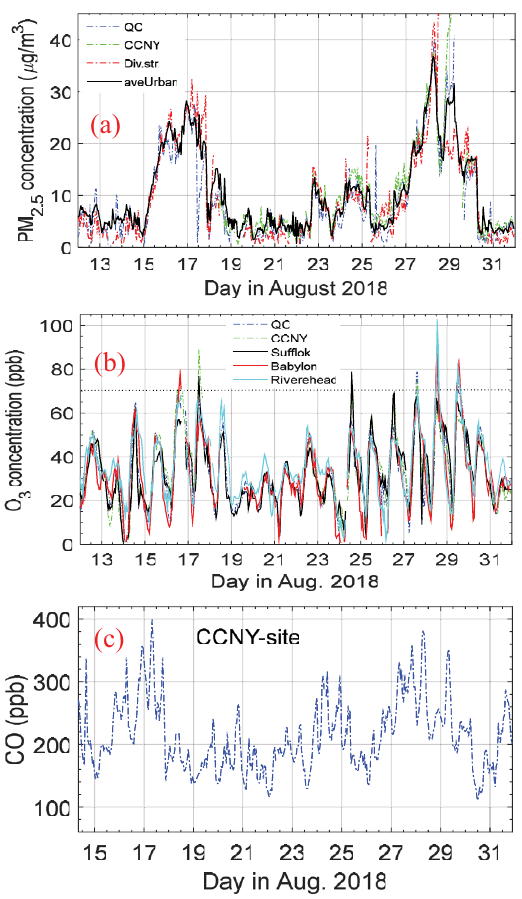
Fig.3 (a)-(c) Ground-level PM 2.5 , O 3 and CO variation in NYC during Aug.12-31, 2018.